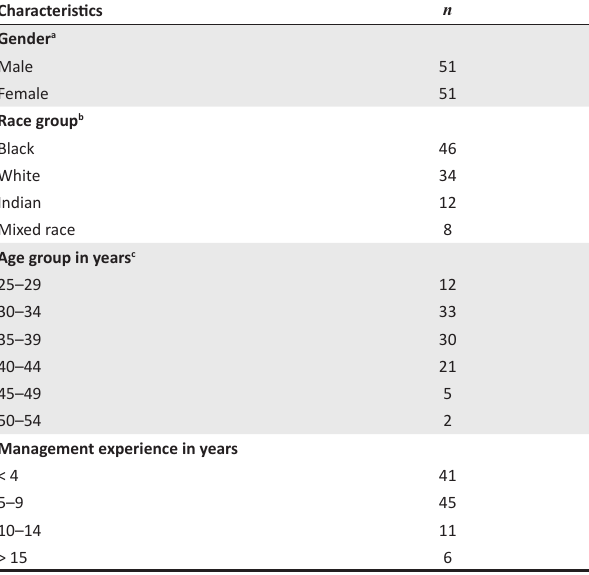
TABLE 2: Sample characteristics. Characteristics